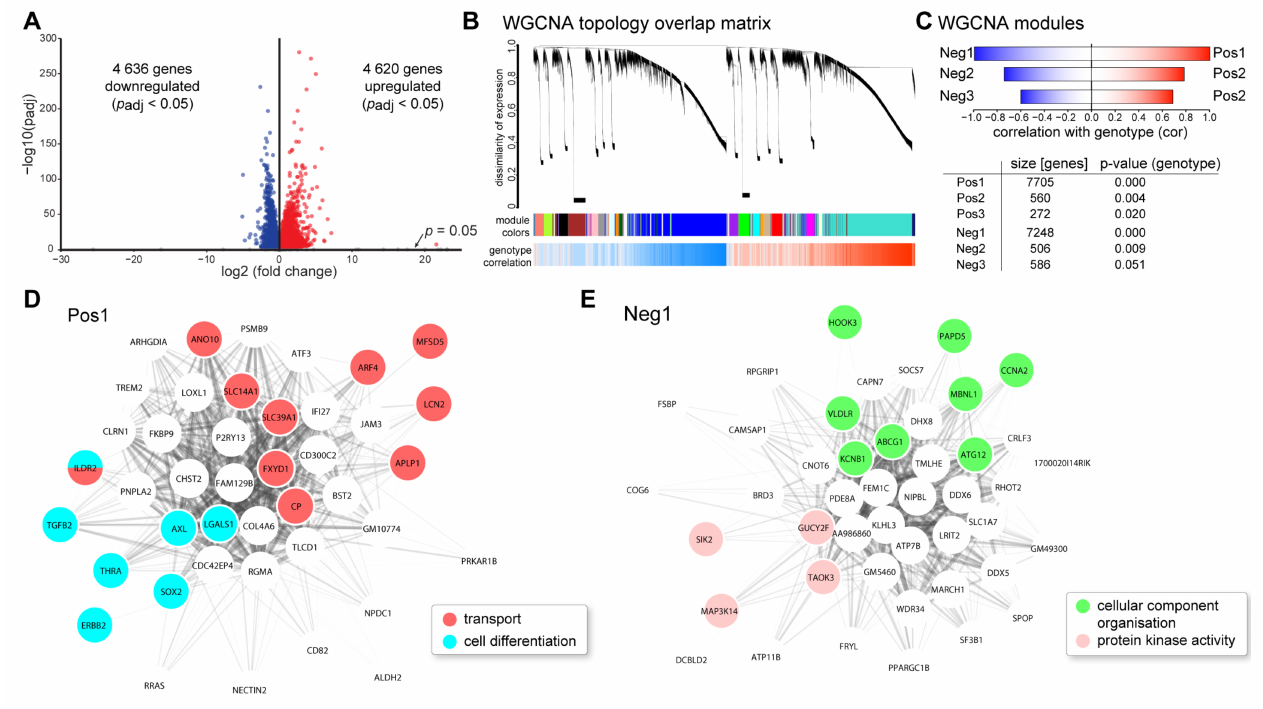
Figure 1. Transcriptome analysis of VPP mice: ( A ) RNAseq analysis of three-month-old identified more than 4600 significantly down- and up-regulated genes, respectively (Benjamini–Hochberg adjusted p -values; p adj ). ( B ) Weighted correlation network analysis (WGCNA) showed large clusters of genes (modules) that were positively or negatively correlated with the genotype. Blue color in the panel below indicates lower expression and red color indicates higher expression in the VPP mice. ( C ) For each sign of correlation, three significantly correlated modules that changed in the VPP mice were identified. ( D , E ) Intra-module analysis of the Pos1 ( D ) and Neg1 ( E ) modules. The 50 highest connected (intramodular connectivity) genes are shown. Coloring of the genes corresponds to significantly enriched gene ontology